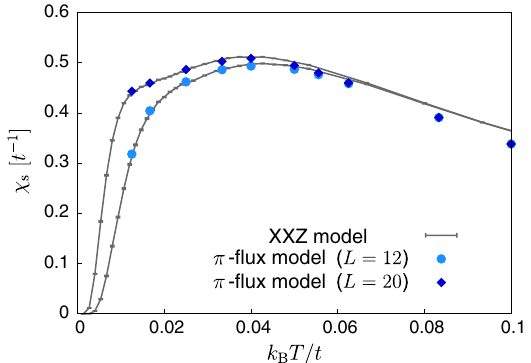
FIG. 12. Spin susceptibility as a function of temperature. Symbols correspond to quantum Monte Carlo results for the Kane-Mele-Hubbard model ( (cid:4)=t ¼ 0 : 2 , (cid:5) ¼ 0 , U=t ¼ 4 ) on L (cid:4) 12 lattices with L= 2 (cid:1) fluxes arranged in a periodic one- dimensional chain. Lines are quantum Monte Carlo results for the one-dimensional XXZ model with J zz = j J xy j ¼ (cid:2) 0 : 1 and L= 2 lattice sites